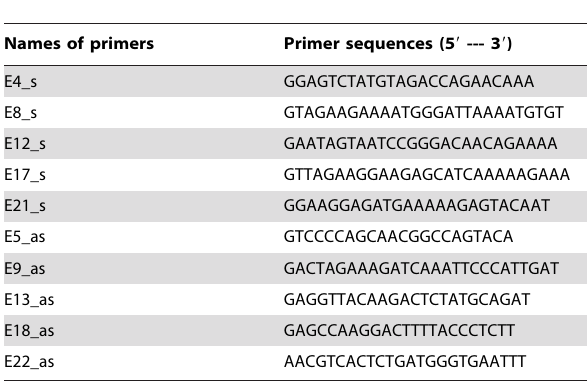
Table 1. Primers used for sequencing of ErbB4 cDNA clones. Names of